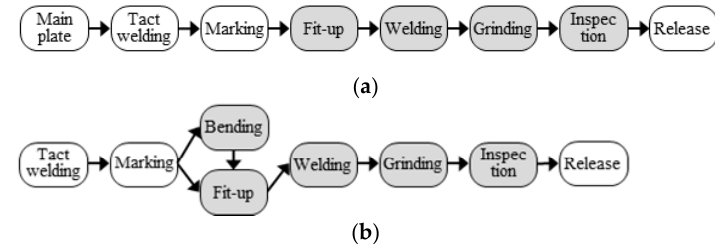
Figure 4. The production process definition of large assembly blocks: ( a ) production process of a panel block, and ( b ) production process of a curved block. Table 2. Production process detailed descriptions for large assembly blocks.